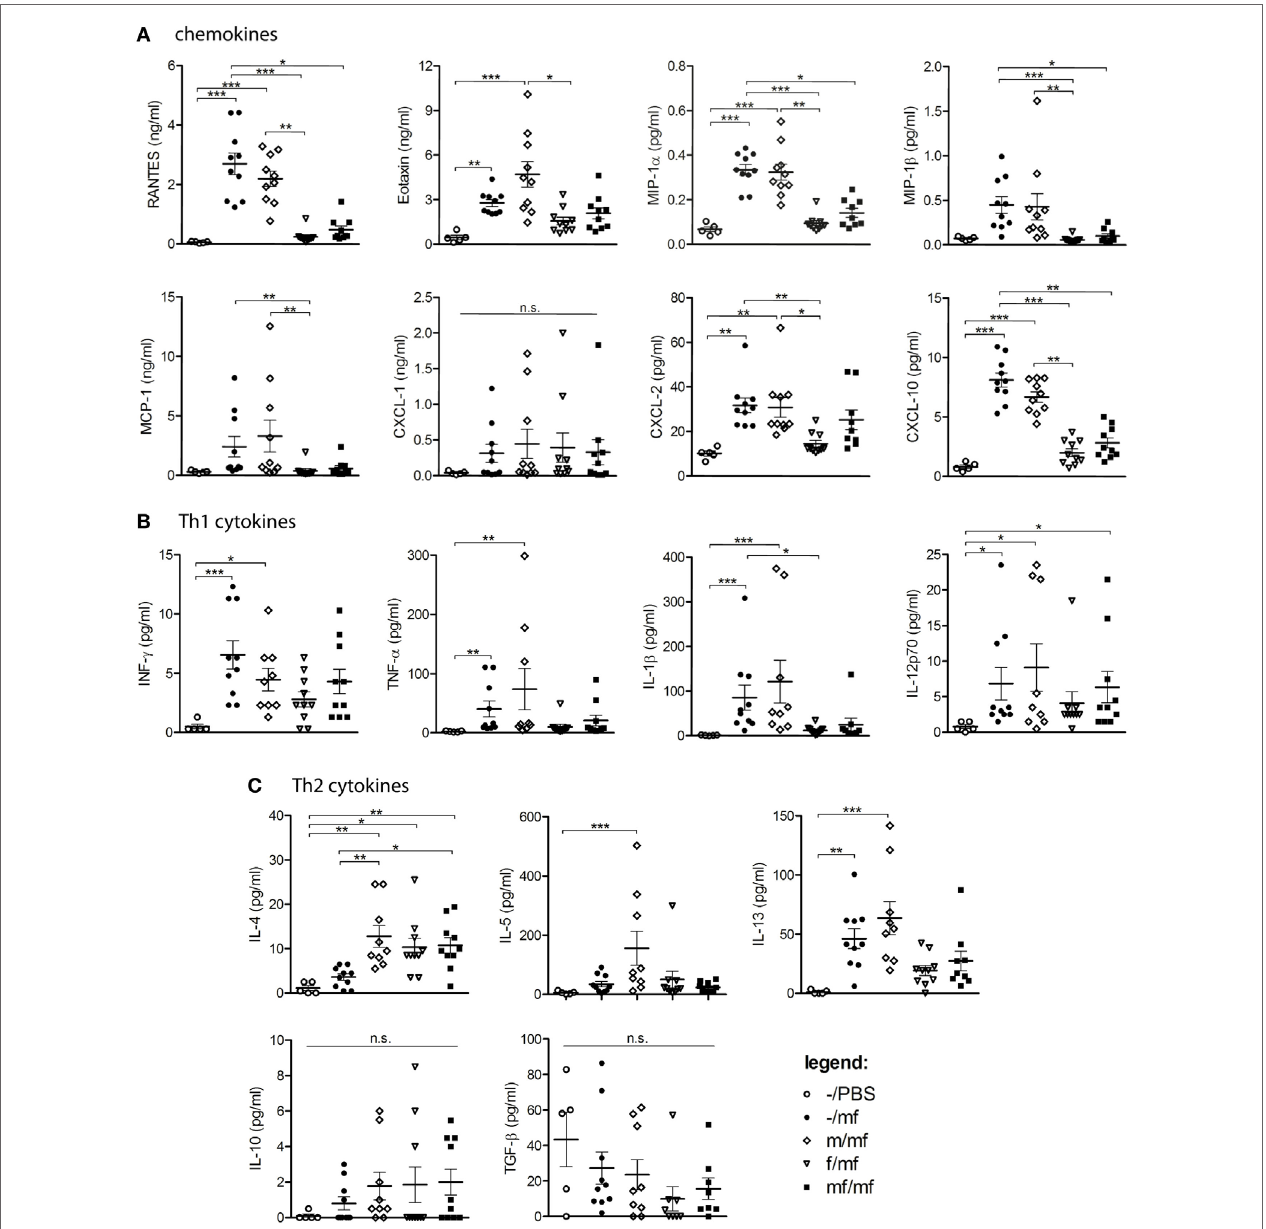
FigUre 2 | Multiplex analysis: female schistosomes reduce chemokine and cytokine production. Concentrations of (a) chemokines (RANTES, Eotaxin, MIP-1 α , MCP-1, CXCL-1, CXCL-2, CXCL-10), (B) Th-1 cytokines (INF-y, TNF- α , IL-1 β , IL-12p70), and (c) Th2-cytokines (IL-4, IL-5, IL-13, IL-10, TGF- β ) were analyzed in air pouch exudates of Schistosoma mansoni -infected mice. Data from individual experiments are depicted as individual symbols, lines represent mean ± SEM; n = 5 or 10 mice each group; * p < 0.05, ** p < 0.01, *** p < 0.001, n.s., not